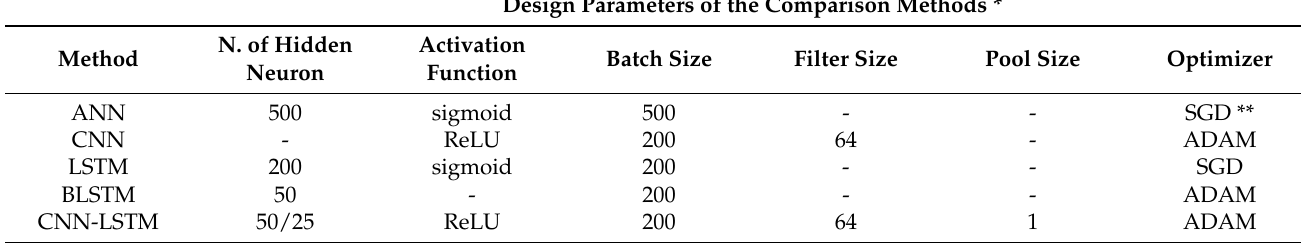
Table 2. Parameter settings of comparison models. Design Parameters of the Comparison Methods